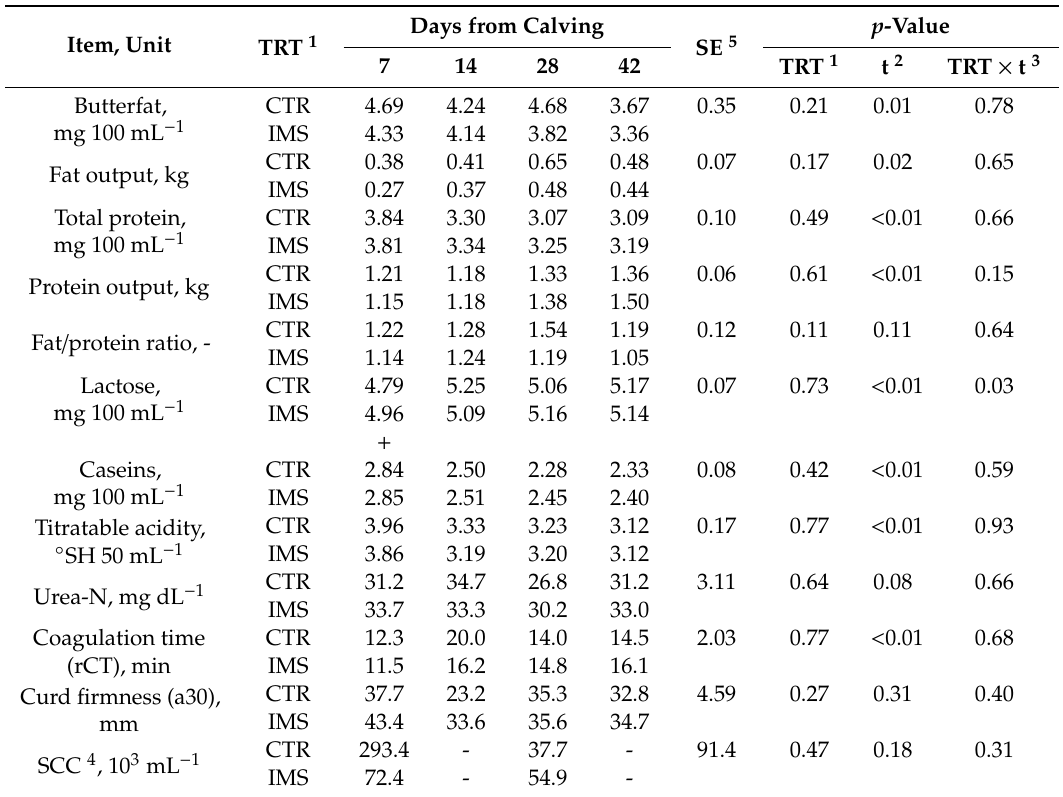
Table 2. Milk composition, rheological measurements, and somatic cell count in control dairy cows (n = 5) or cows receiving 65 g*d − 1 of Omnigen-AF ® as top-dress between − 55 and 42 days from calving (n =